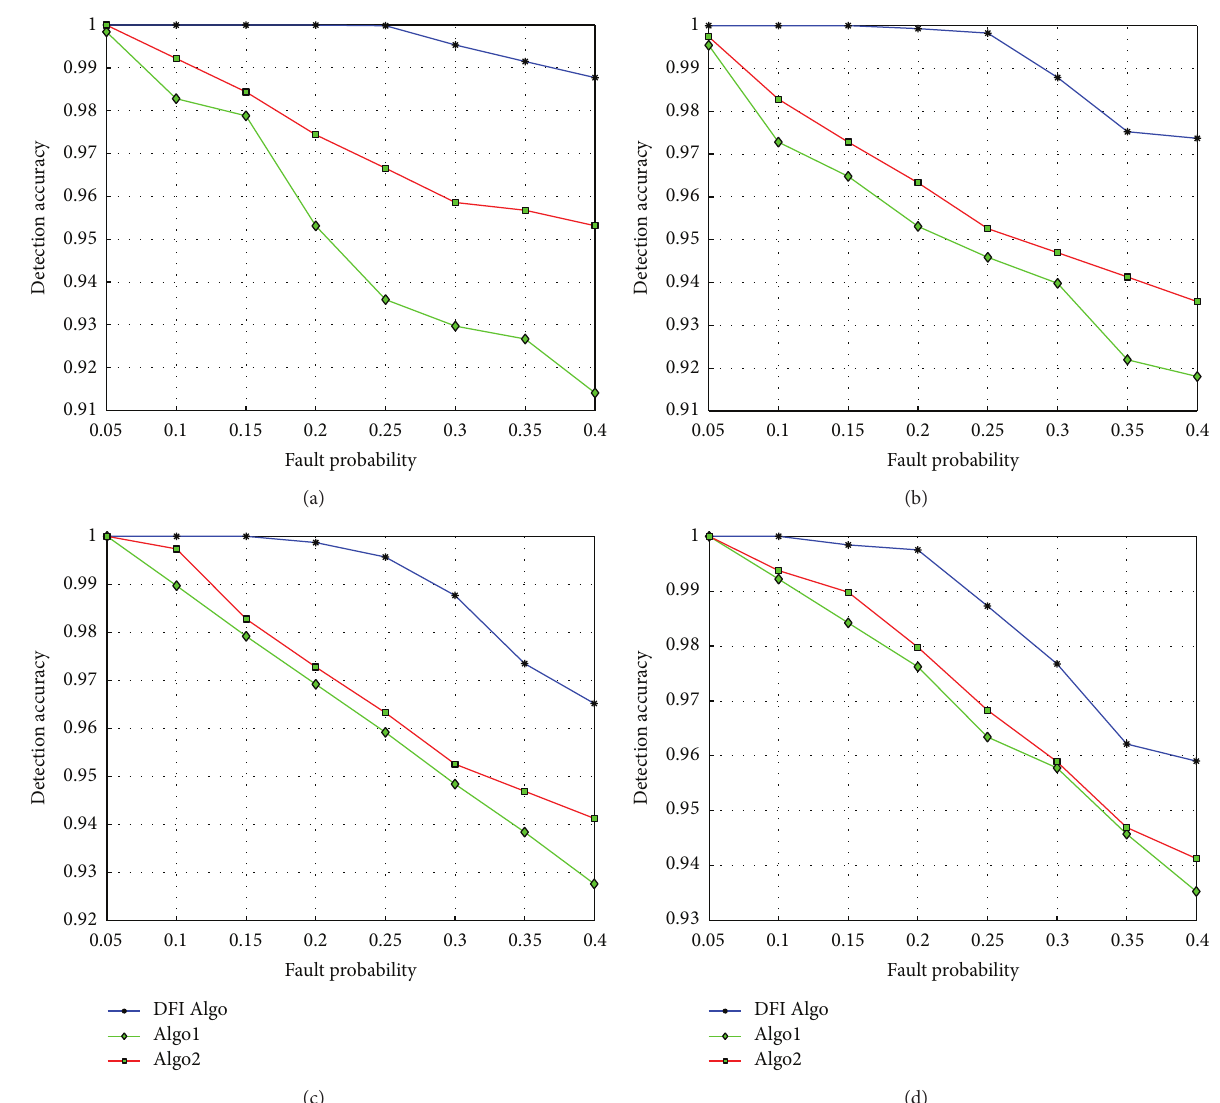
Figure 2: DA versus fault probability plots obtained by the proposed DFI, Algo1, and Algo2 algorithms: (a) for average degree 𝑁 𝑎 = 10; (b) for average degree 𝑁 𝑎 = 15; (c) for average degree 𝑁 𝑎 = 20; (d) for average degree 𝑁 𝑎 =